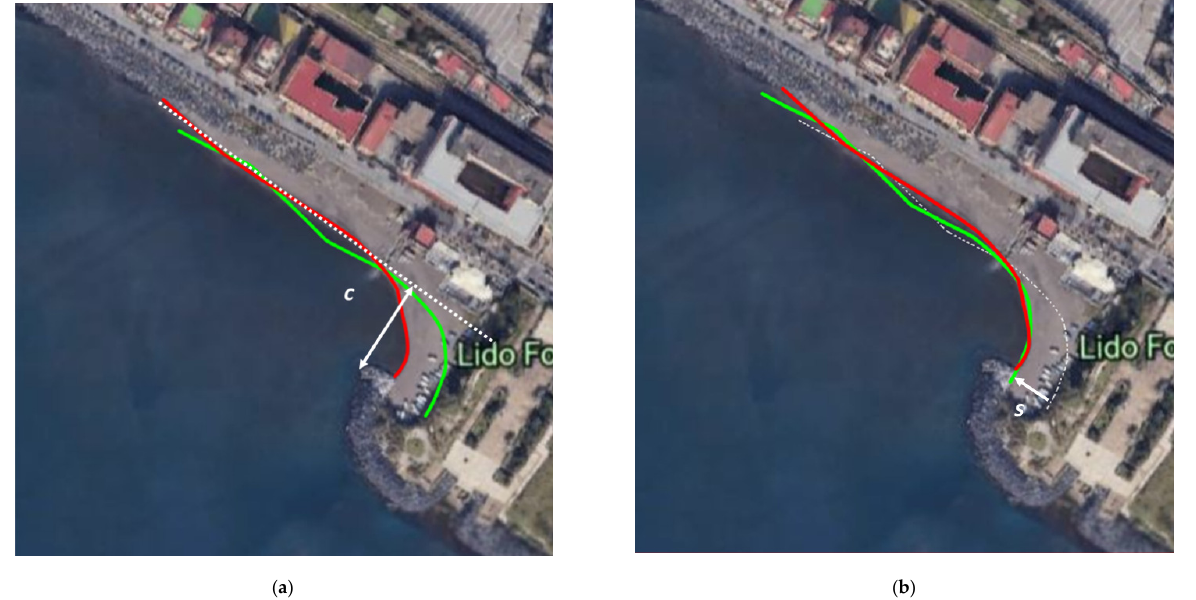
Figure 19. ( a ) Wave front (green line) that overlaps the shoreline (red line) in the downdrift section and the latter’s distance, c, from the diffraction point; ( b ) wave front shifted by s, which was derived from Equation (15).